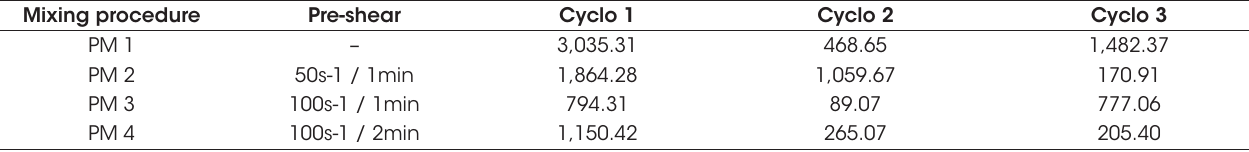
Hysteresis area of the mixing processes for different pre-shear tests performed by the rheometer Mixing procedure